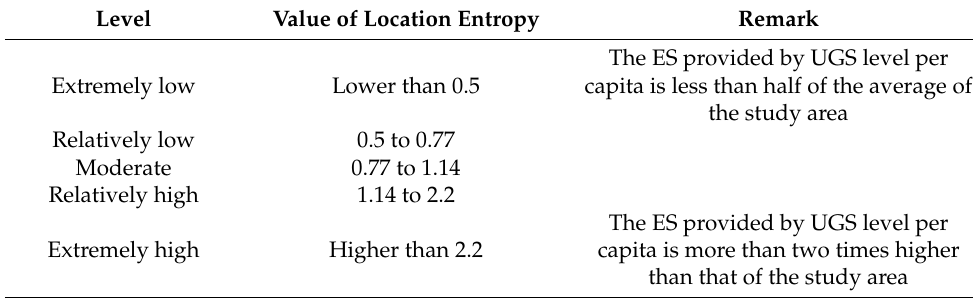
Table 2. Location entropy characterized by equity grade in this study